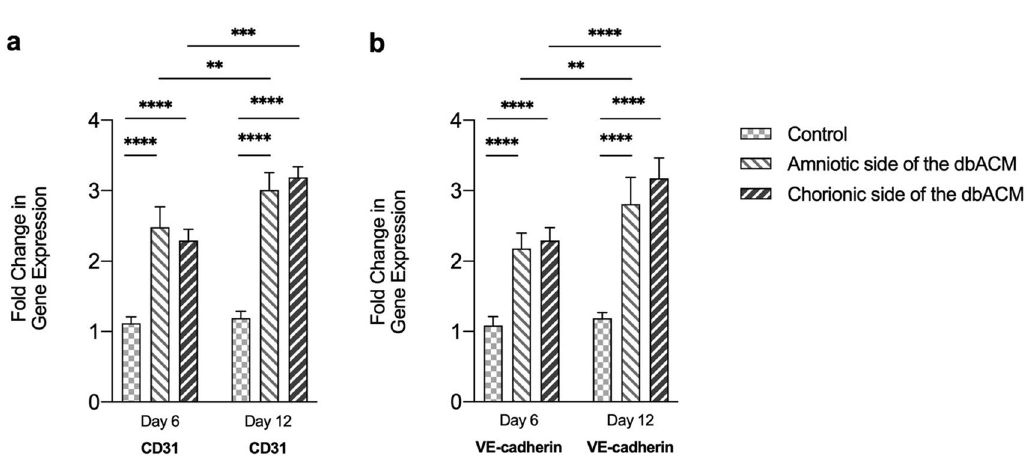
Figure 7. Evaluation of gene expression of CD31 and VE-cadherin in HUVECs cultured on amniotic and chorionic side of dbACM in days 6th and 12th. Values are expressed as the mean ± S.E.M (n = 5) results